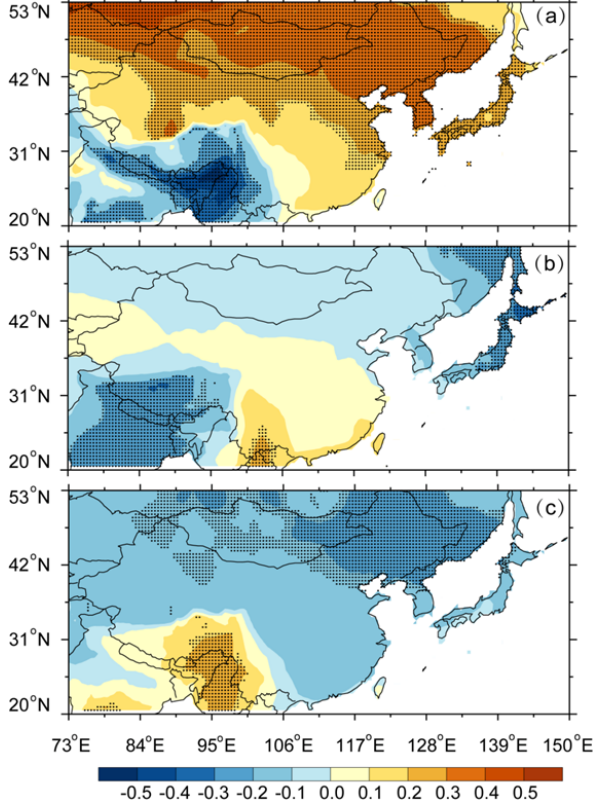
Figure 11. Spatial distribution of the correlation coefficient be- tween detrended dynamically induced temperature and detrended NAO (a) , PDO (b) , and AMO (c) in the cold season from 1902 to 2011 over east Asia. The stippling indicates the 95% confidence level according to a two-tailed Student’s t test.